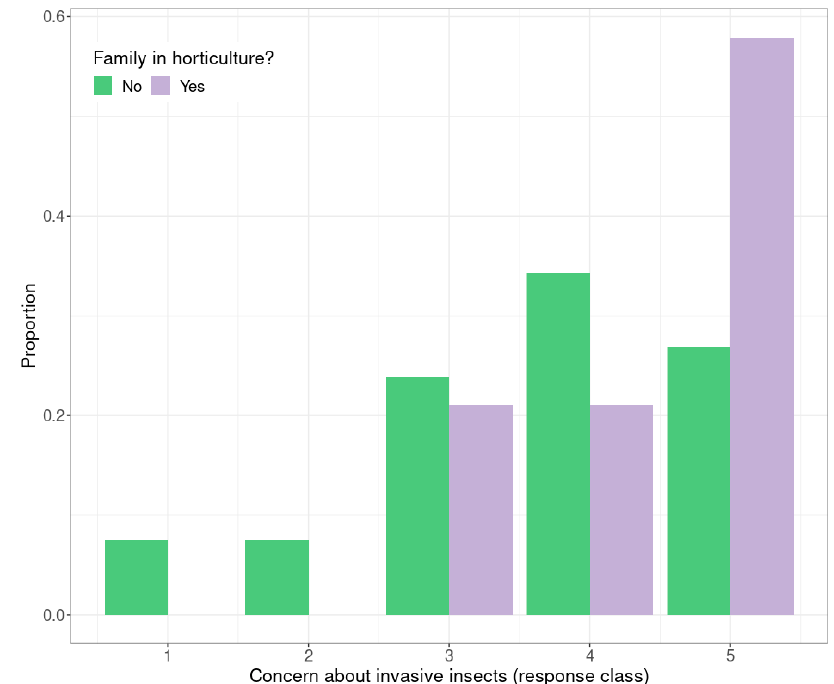
Figure 4. Proportion of survey respondents with family in horticulture compared with members of the public with no family in horticulture that have concern of invasive species. The scale ranges from 1 to 5 (1 = not very concerned, 5 = very concerned about invasive pest insects).